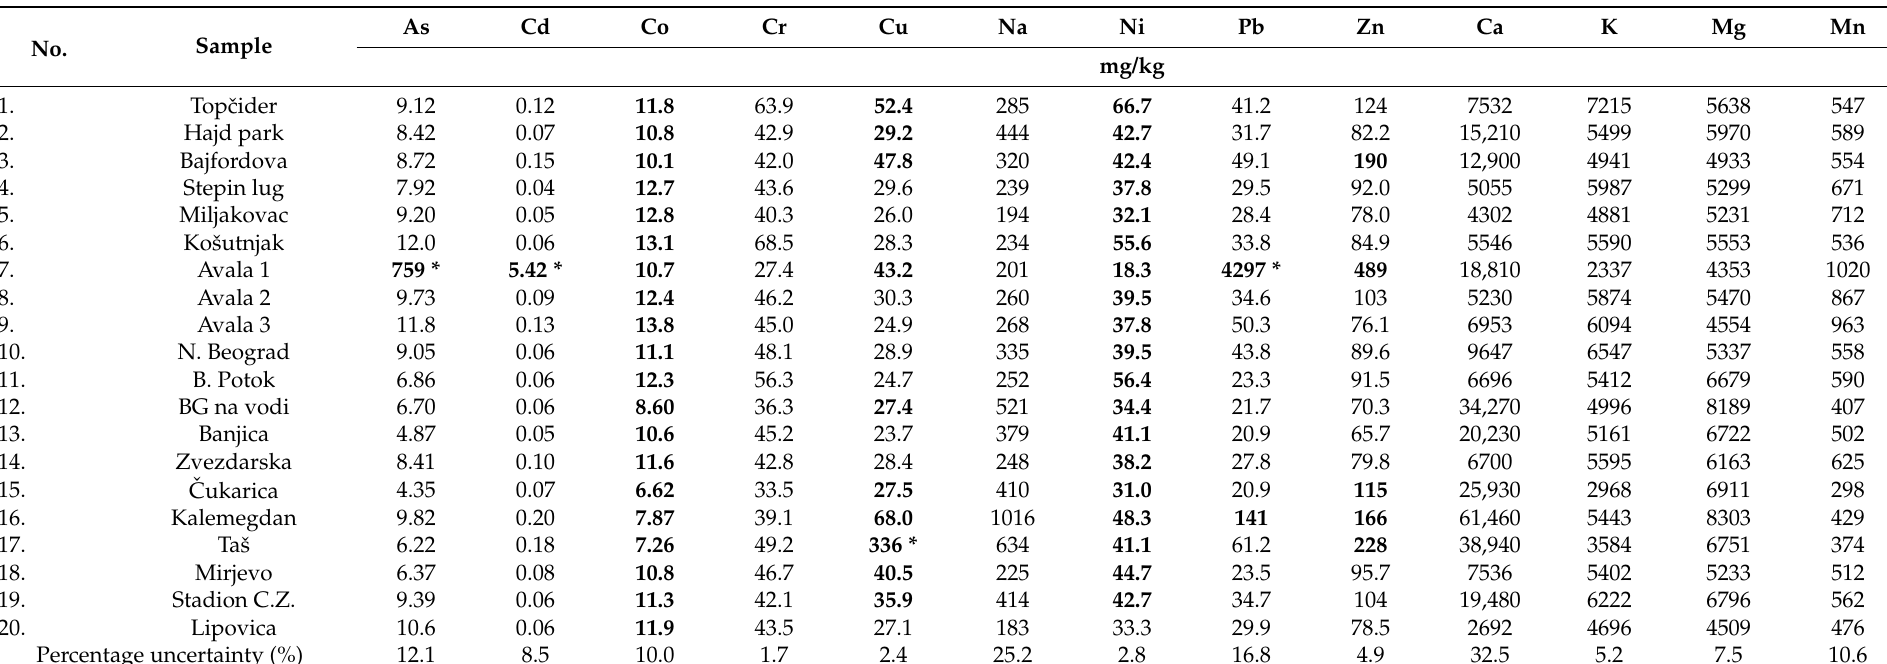
Table 3. Content of As, Cd, Cr, Co, Cu, Na, Ni, Pb, Zn, Ca, K, Mg, and Mn (mg/kg) in soil and the measurement uncertanties of the method. The results exceeding corrected target values are written in